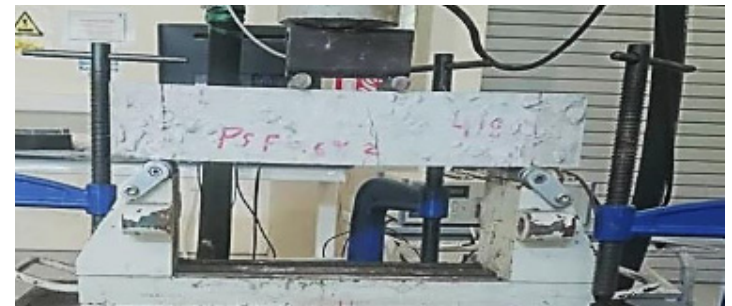
Figure 1. Concrete Testing ( a ) Compressive Strength Test ( b ) Split Tensile Strength Test.